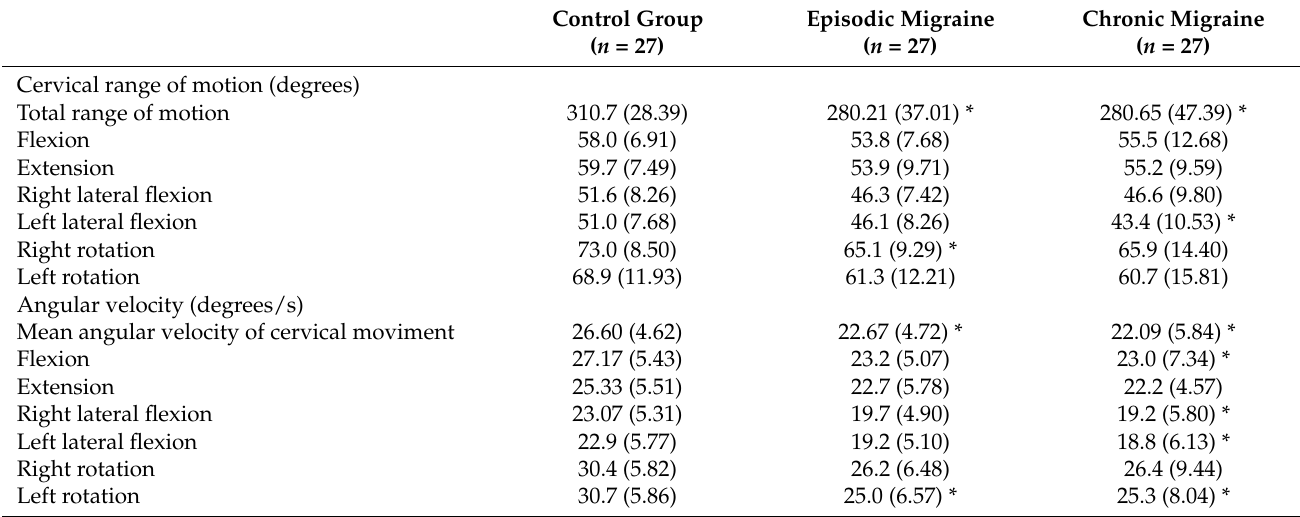
Table 2) among the groups were observed. Table 2. Mean and standard deviation of cervical range of motion angle and angular